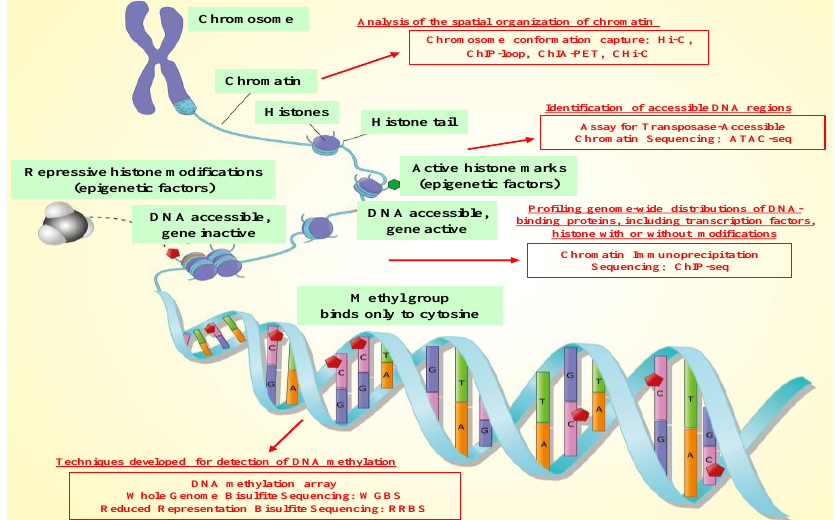
Figure 1. The summarized figure of epigenetic regulations and technologies for epigenetics analysis. Image credit: Shutterstock.com/ellepigrafica.